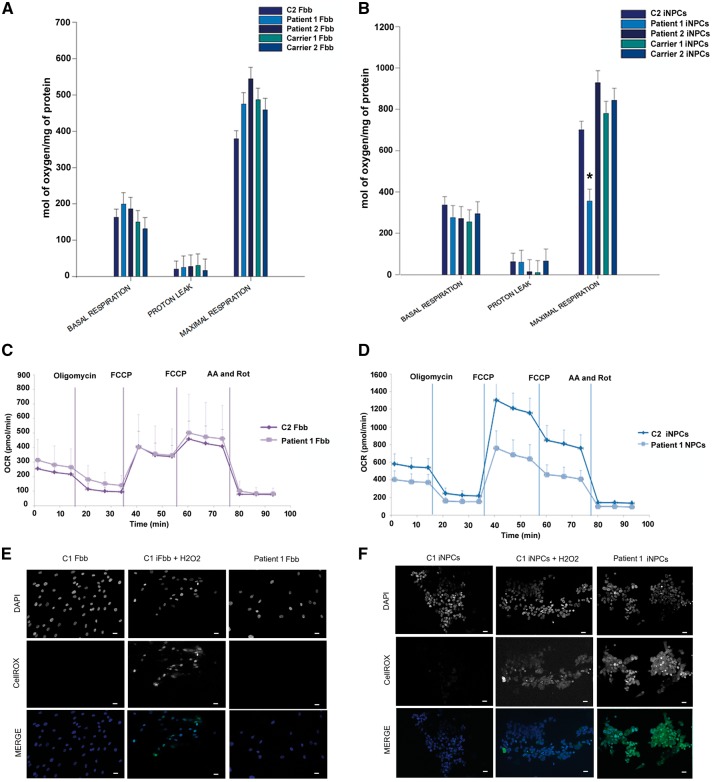
Mitochondrial functional studies. Oxygen consumption levels were monitored using the Seahorse Bioscience ExtraCellular Flux Analyser in real time. OCR is indicative of OXPHOS. Basal respiration, proton leak and maximal respiration of fibroblasts (A) and iNPCs are shown (B). Values were calculated from the mean values of each real-time run normalized to the protein concentration (n = 3). Oxygen consumption data are presented as ± standard deviation using two-way ANOVA test on Sigma plot (version 11.0) and paired t-test. A P-value of ≤0.05 was considered significant. The P-values are from an unpaired t-test. Where indicated *P < 0.05. (C, D) Real-time effect of control and patient 1 cells (GARSHis216Arg) is demonstrated on OCR in fibroblasts and in iNPCs. (E, F) Fluorescent micrographs of control and fibroblasts and iNPCs of patient 1 show intracellular ROS formation as stained by the CellRox Green Reagent. Light green fluorescence indicates increased levels of oxidative stress in H2O2-treated cells as positive controls and in iNPCs of patient 1. DAPI shows nuclei. Scale bar = 20 μm.